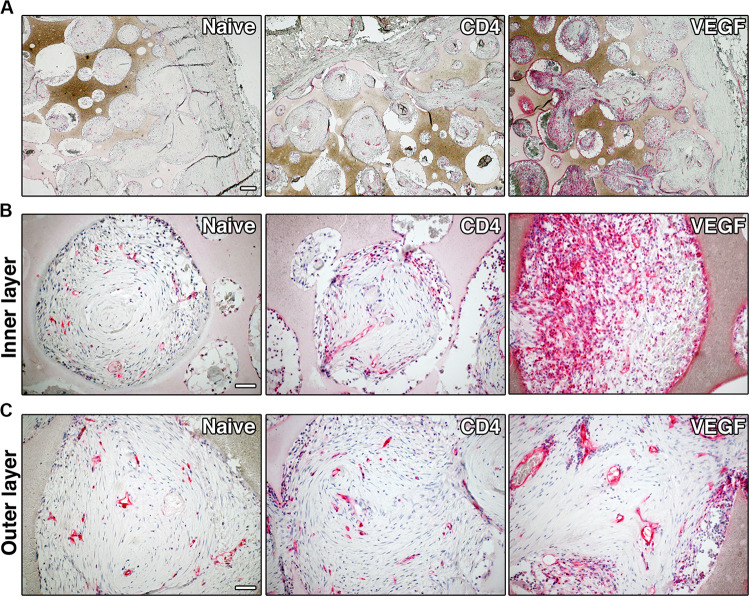
Representative images of graft sections immuno-stained for CD31, showing blood vessels (in red), at low-magnification (A, size bar = 200 μm) and high-magnification (B, inner layer and C, outer layer, size bar = 50 μm).